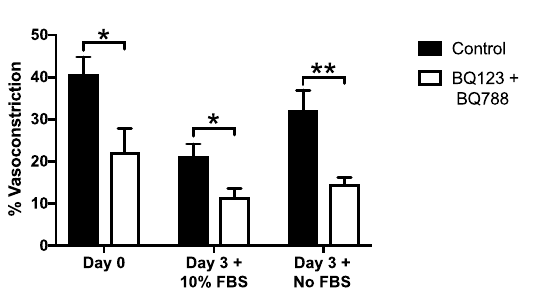
Figure 2. Qualitative evaluation of ex vivo tissue viability between Day 0 (pre-culture) and Day 3 (cultured) mesenteric tissues. ( A–C ) Cell viability/cytotoxicity labeling with Calcein AM (green) and Ethd-1 (red) confirms tissues remain viable up to three days in the rat mesentery culture model. Scale bars = 200 μ m. A = arteriole, V = venule.